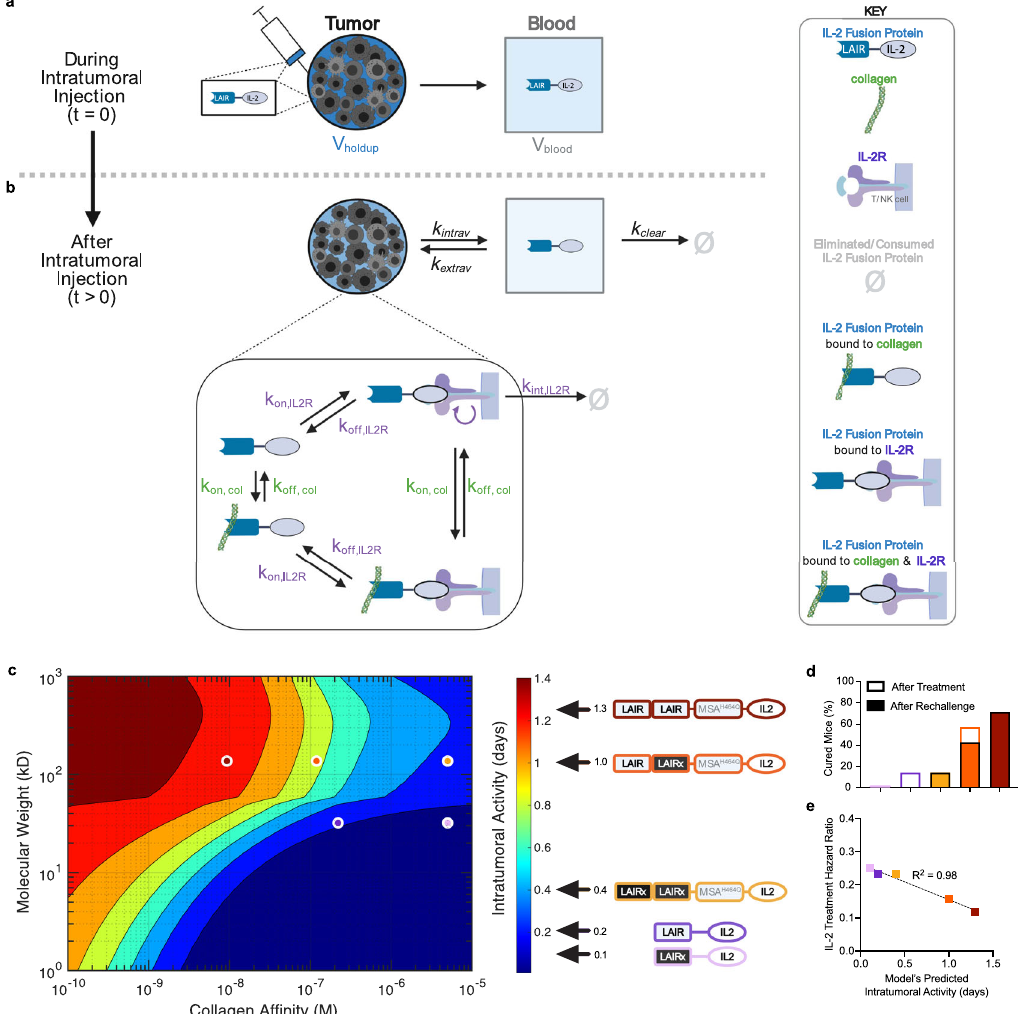
Fig. 2 Pharmacokinetic model predicts response to local IL-2 therapy. Model simulating the disposition of intratumorally injected IL-2 collagen-binding fusion protein over time (t). a During an intratumoral injection, IL-2 fusion protein is instantaneously transferred from the syringe to the tumor compartment (circle) of volume capacity V holdup and blood compartment (square) of volume V blood b After injection, diffusion of the injected protein between the tumor and blood compartment occurs based on the rate of intravasation ( k intrav ) and extravasation ( k extrav ). Removal of the injected protein from blood occurs at a rate of clearance ( k clear ). Ø indicates removed protein. The italicized rates depend on the molecular weight of the injected protein. Within the tumor interstitium (inset), the injected protein toggles between target-bound states. The injected protein (free or collagen-bound) binds IL-2 receptor (IL-2R) according to rate of association ( k on,IL2R ) and dissociation ( k off,IL2R ) with IL-2R. When bound to IL-2R, the injected-protein-IL-2R complex is internalized and degraded at the rate of IL-2R internalization ( k int,IL2R ). IL-2 signaling increases the concentration of IL-2R over time. The injected protein (free or IL-2R bound) binds collagen according to the rate of association ( k on,col ) with collagen and rate of dissociation with collagen ( k off,col ). Glossary of the model ’ s variables, initial conditions, and equations are provided in Supplementary Tables 1 – 3. c Model ’ s prediction of the intratumoral activity duration of an injected IL-2 fusion protein varying in molecular weight (kD) and collagen af fi nity ( K d equilibrium dissociation constant in M units) The circles on the heatmap indicate the model ’ s prediction for the proteins LAIR-LAIR-MSA H464Q -IL2 (red), LAIR-LAIR x -MSA H464Q -IL2 (orange), LAIR x -LAIR x -MSA H464Q - IL2 (yellow), LAIR-IL2 (purple), and LAIR x -IL2 (pink). Each protein ’ s predicted days of activity is adjacent to color bar. d Percentage of mice from Fig. 1h, i surviving 100 days after treatment (outlined box). On day 100, surviving mice were inoculated with 0.1 M B16F10 on the contralateral left fl ank. The percentage of mice surviving for another 100 days after tumor rechallenge ( fi lled box). e Correlation between the model ’ s predicted intratumoral activity in panel c and hazard ratio for treatments from Fig. 1h, i compared to PBS (i.tu.) + TA99 (i.p.) treated control group. Hazard ratio computed by log-rank method. Source data for panel d , e are provided in the Source Data fi le. Panel a and b created with